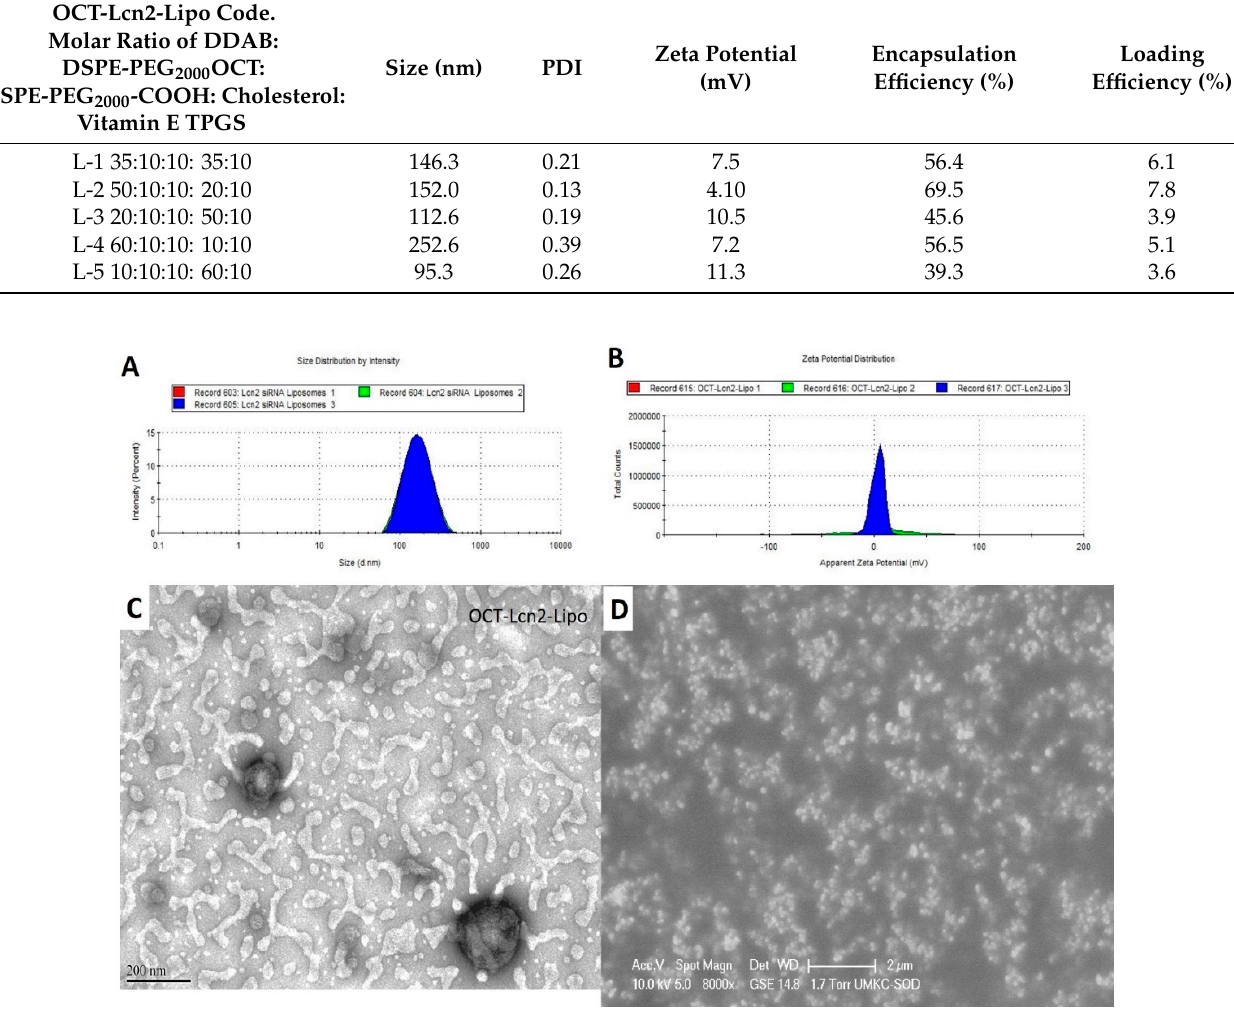
Figure 4. Octreotide-targeted Lcn2-siRNA encapsulated liposomes (OCT-Lcn2-Lipo) morphological characterization. ( A ) Hydrodynamic size, ( B ) Zeta potential, ( C ) Transmission electron microscopy (TEM) image of liposomal formulation in liquid state and ( D ) Scanning electron microscopy image (SEM) of liposomal lyophilized formulation. Double chain cationic polymers like DDAB, DSPE-PEG 2000 -OCT, DSPE-PEG 2000